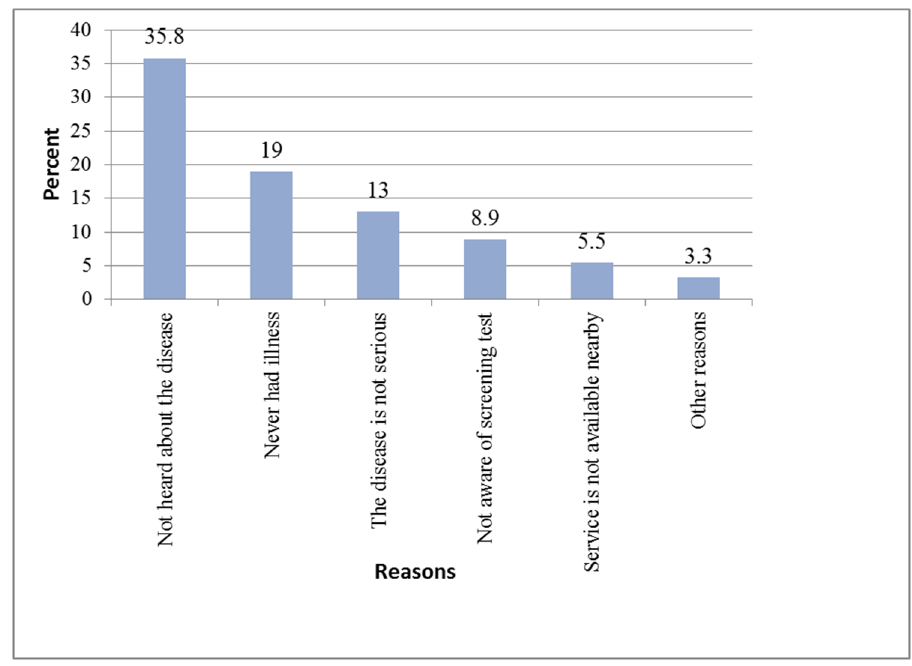
Fig 1. Major reasons for not seeking health for cervicalcancer among respondents.